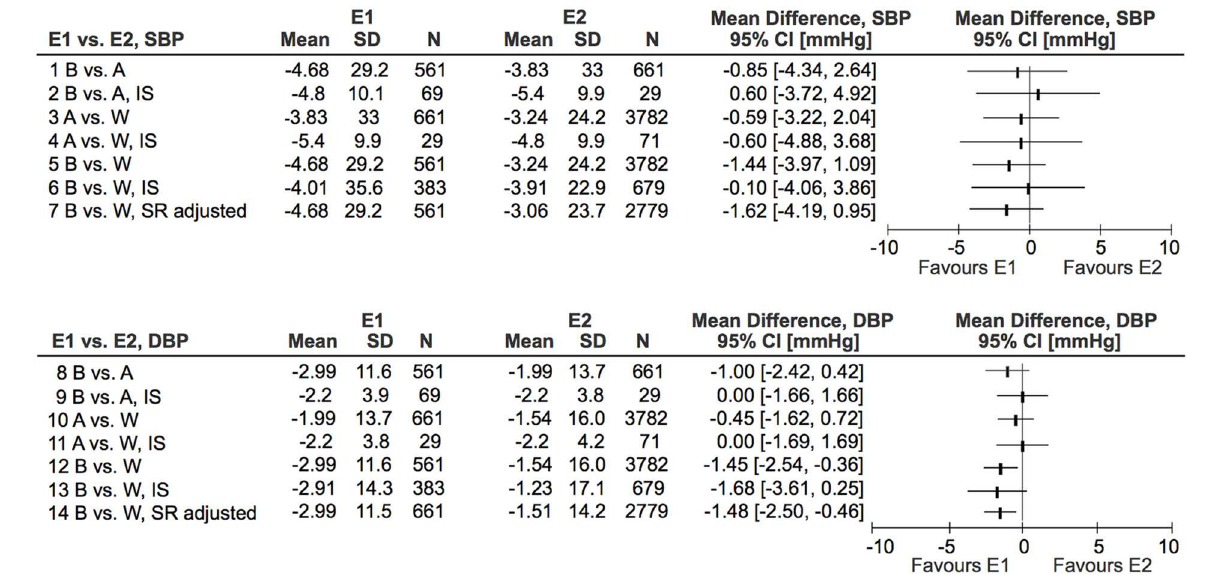
FIGURE 1 | Differences in effect of sodium reduction on systolic and diastolic blood pressure (SBP and DBP) between Asians (A), Blacks (B), and Whites (W). E, Ethnic group; IS, Identical study.